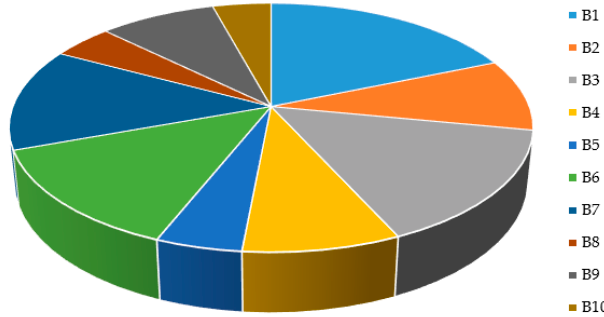
Figure 4. The subjective weight of each evaluation indicator.